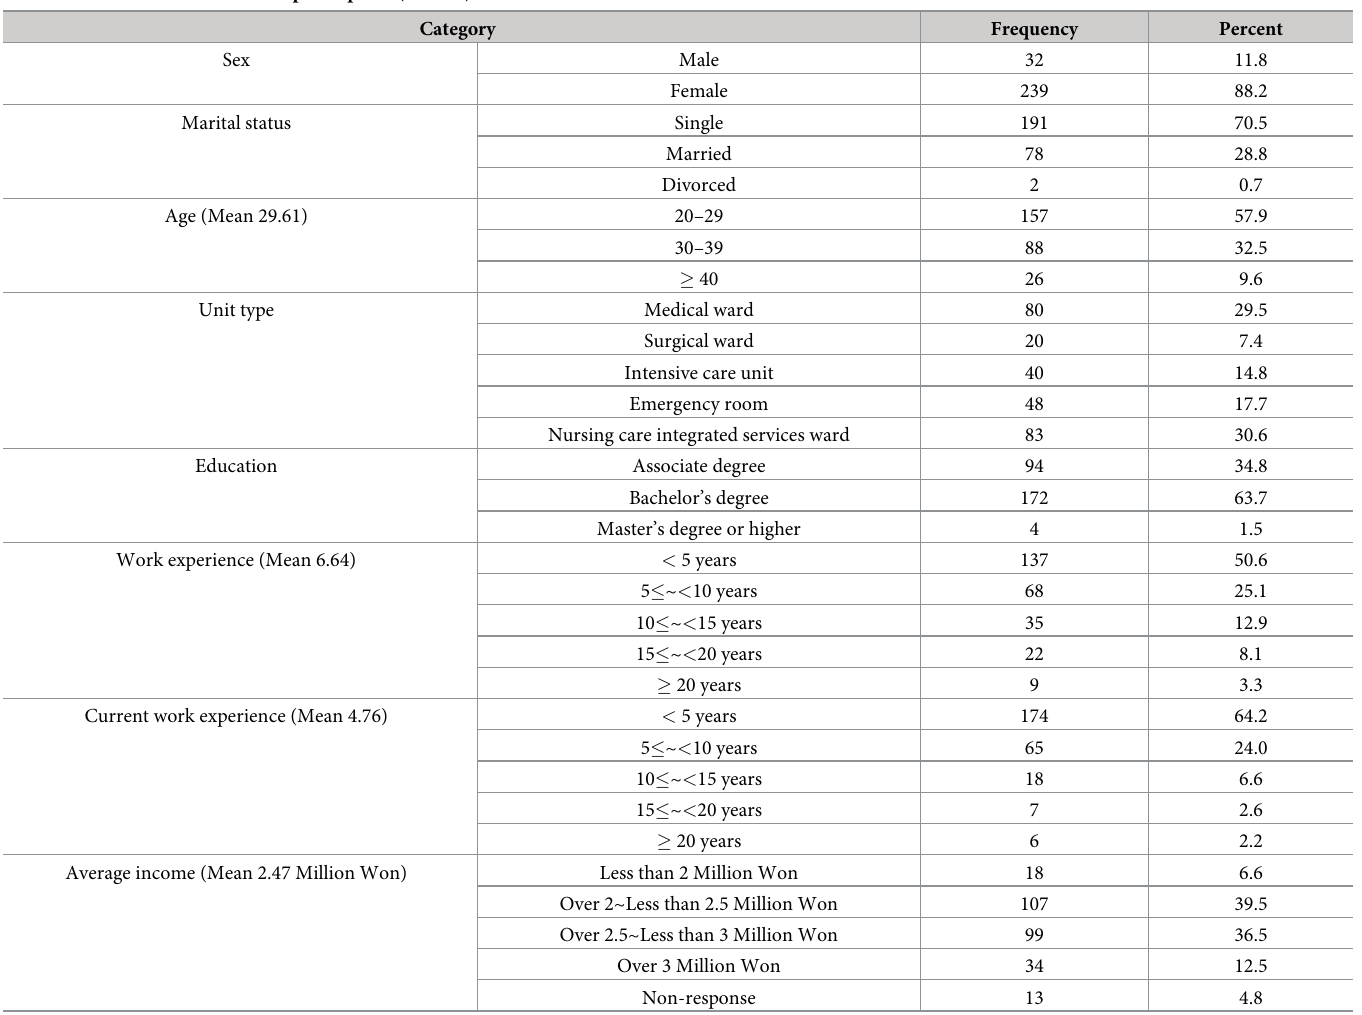
Table 2. General characteristics of participants (n =